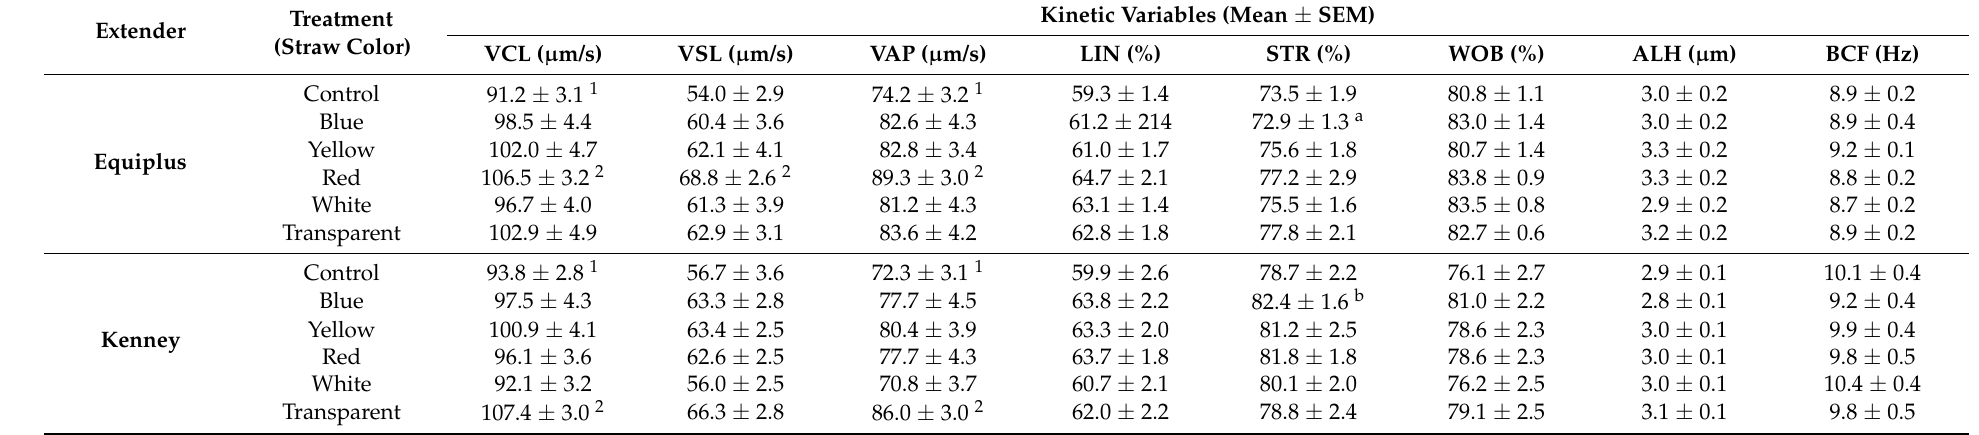
Table 1. Effects of the color of the straw (blue, yellow, red, white, and transparent), extender, and light stimulation on sperm kinetic variables in nonirradiated (control) and irradiated